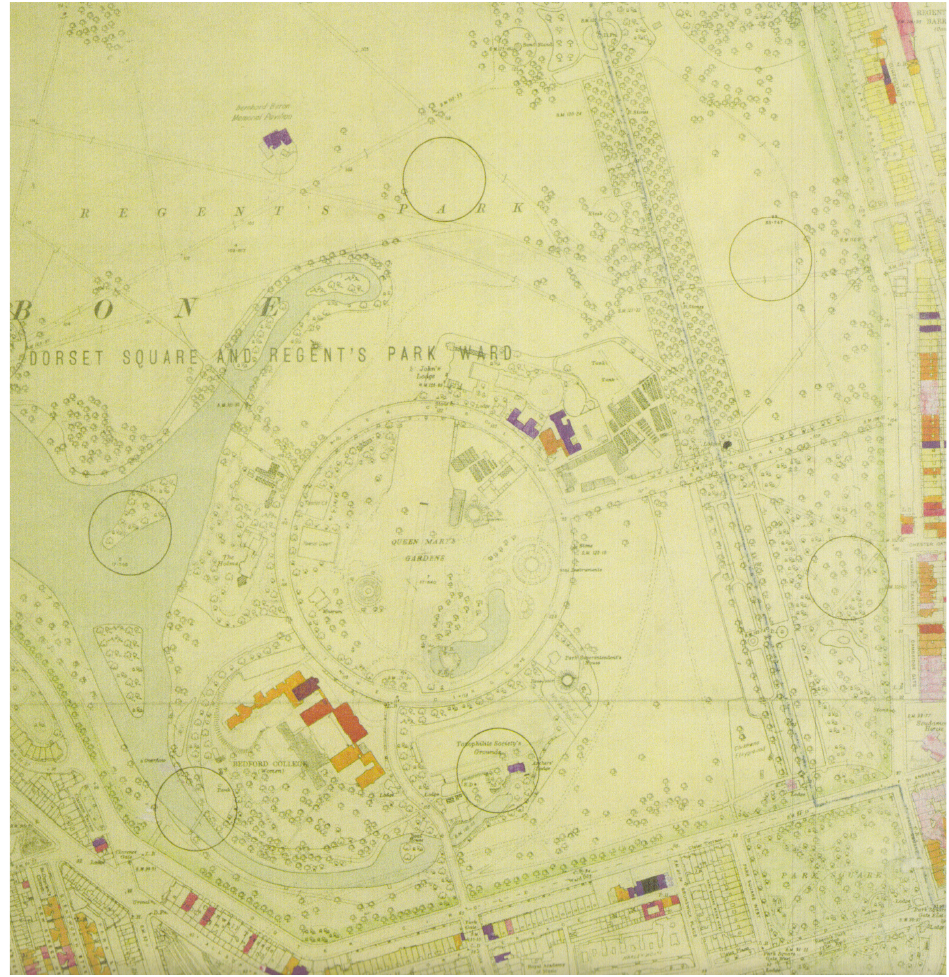
Fig. 4: Bomb damage map with St John’s Lodge at the centre, showing V1 missile impact points as circles, and bomb damage to buildings colour-coded from pale (minor) to dark (severe) (image: © and courtesy of City of London, London Metropolitan